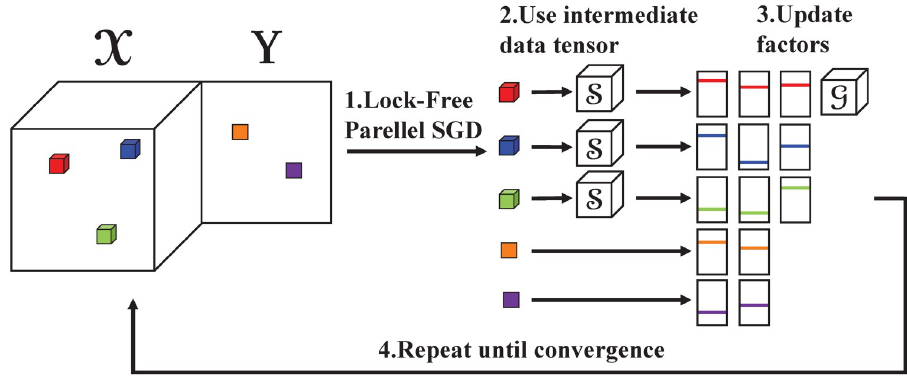
Fig 2. The scheme for S 3